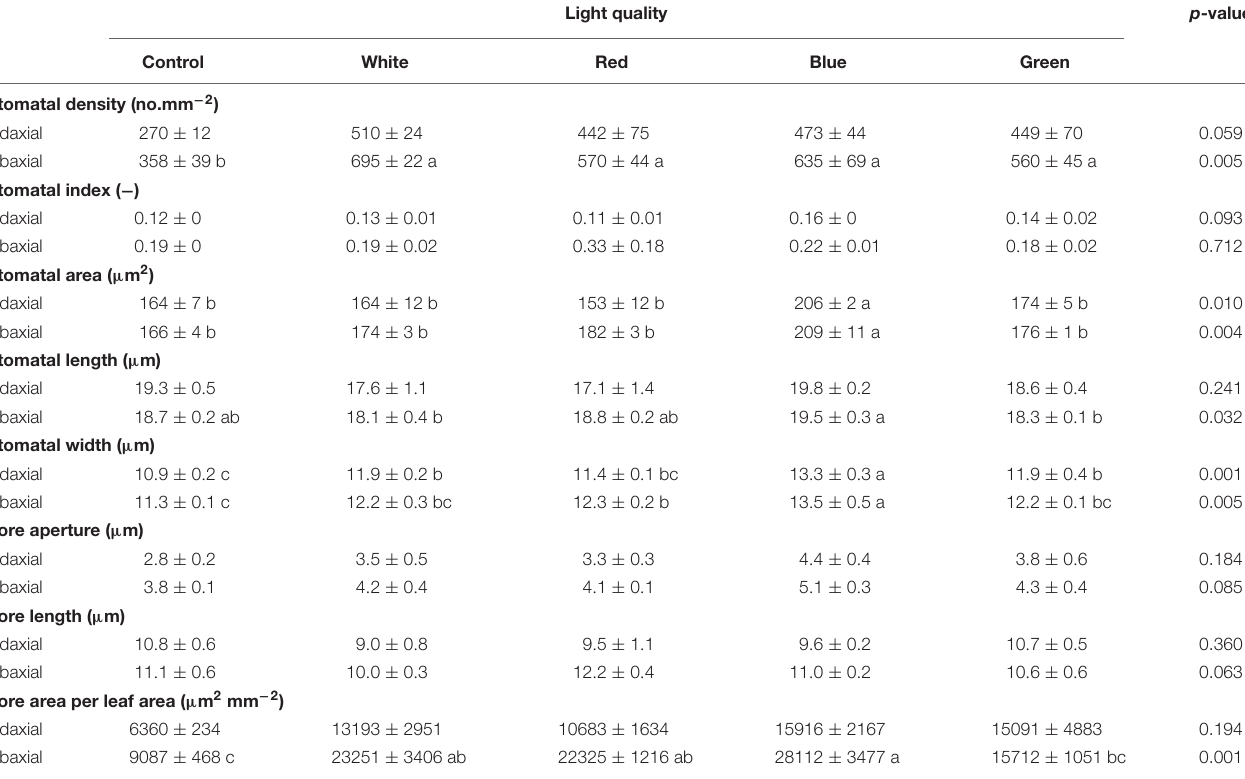
TABLE 4 | Stomatal traits on the adaxial and abaxial surfaces of cucumber